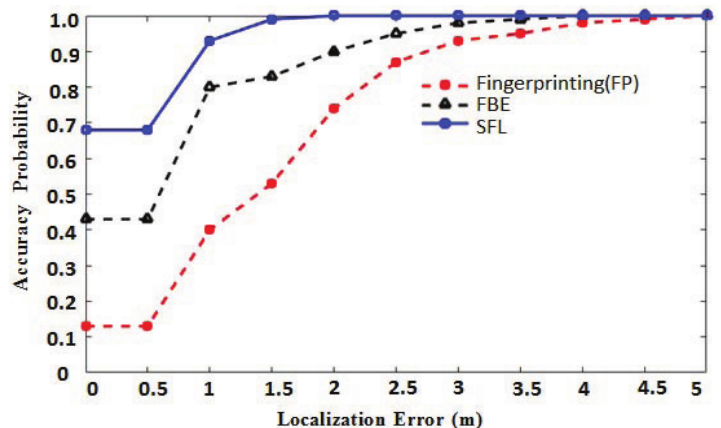
Figure 13. Localization accuracy